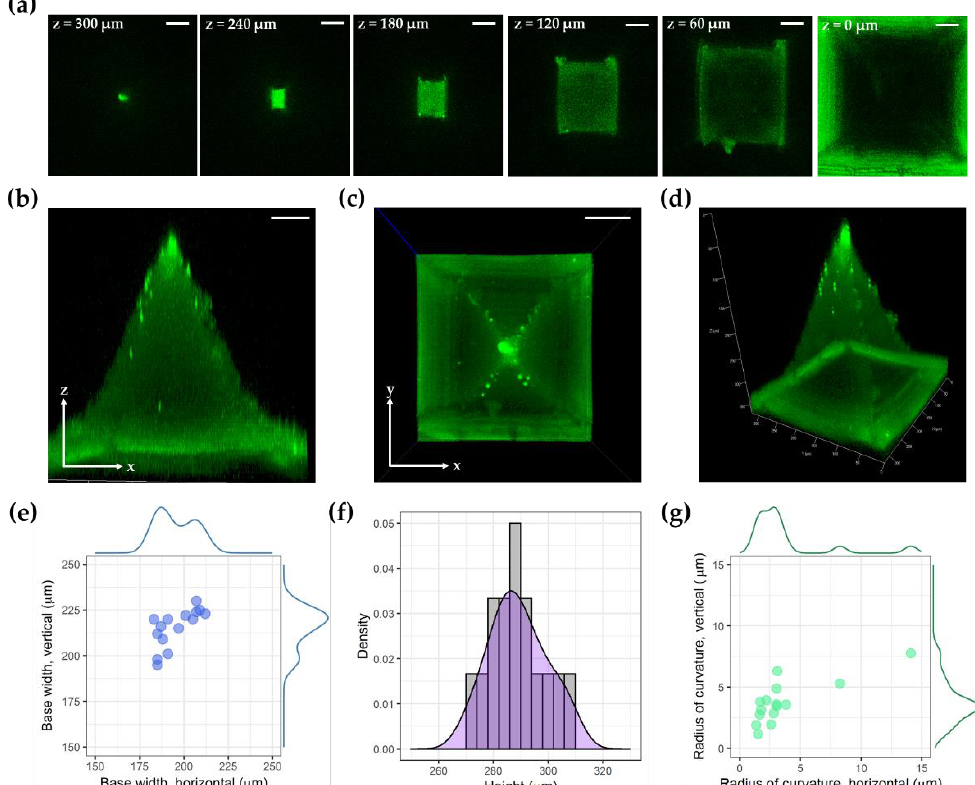
Figure 3. Confocal microscopy imaging of microneedles. ( a ) Cross-sectional images of microneedles with XY cross section at z = 0, 60, 120, 180, 240, and 300 µm; ( b ) Maximum intensity projection (MIP) image by y-directional projection; ( c ) MIP image by z-directional projection; ( d ) MIP image from arbitrary angle; ( e ) Scatter plot for horizontal and vertical widths of the microneedle base; ( f ) Histogram of microneedle heights; ( g ) Scatter plot for horizontal and vertical radii of curvature. Scale bar, 50 µm.